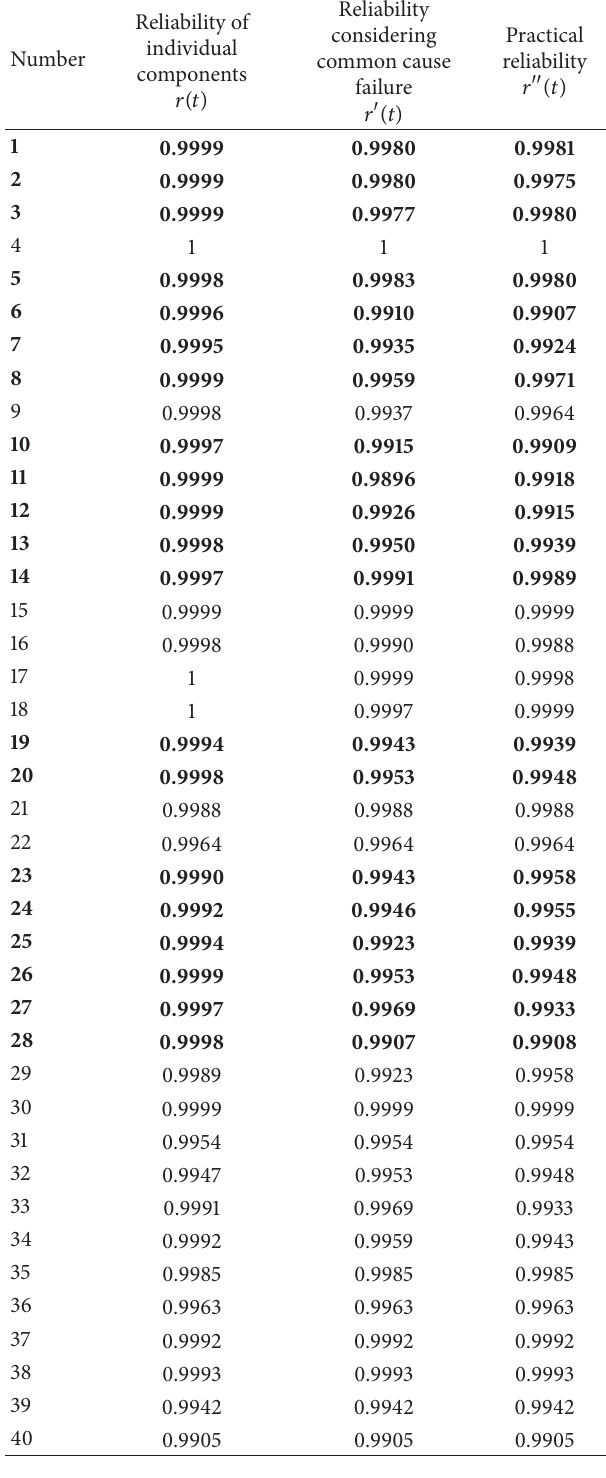
Table 4: Comparison of reliability